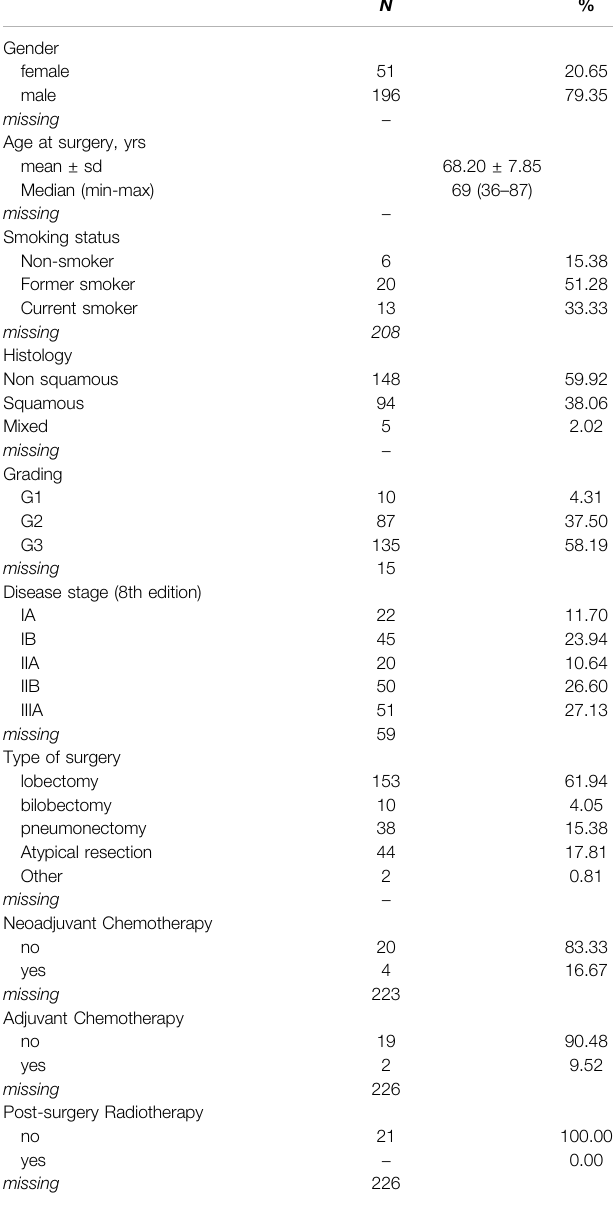
TABLE 1 | Patients characteristics ( n (cid:1)